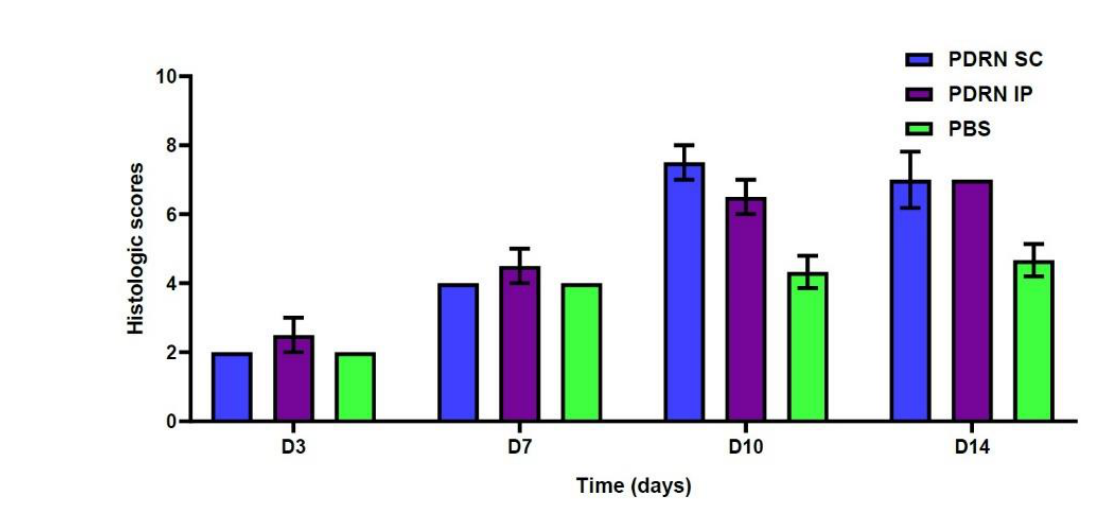
Figure 4. Histologic scores. At 10 days, the PDRN SC group had significantly higher histologic scores as compared with the PBS group (7.5 ± 0.5 versus 4.33 ± 0.47, respectively; p = 0.0055). Likewise, the PDRN IP group had significantly higher histologic scores as compared with the PBS (6.5 ± 0.5 versus 4.33 ± 0.47, respectively; p = 0.0158). At 14 days, the PDRN SC group had significantly higher histologic scores as compared with the PBS group (7.0 ± 0.82 versus 4.67 ± 0.47, respectively; p = 0.0248). Likewise, the PDRN IP group had significantly higher histologic scores as compared with the PBS group (7.0 ± 0.0 versus 4.67 ± 0.47, respectively; p =